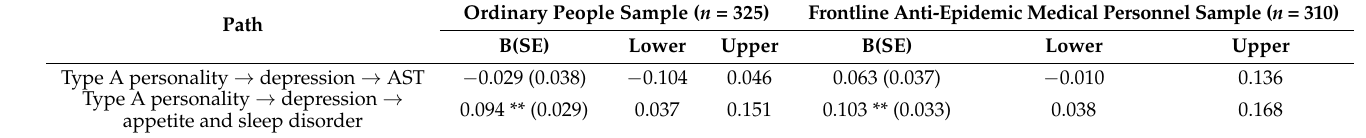
Table 2. Estimates of indirect effects.